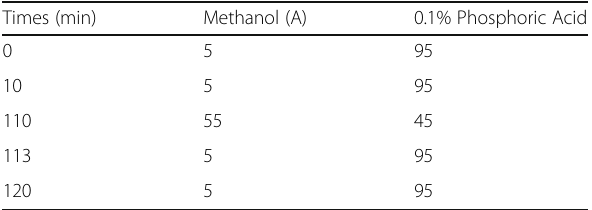
Table 2 Mobile Phase Condition of Chormatographic